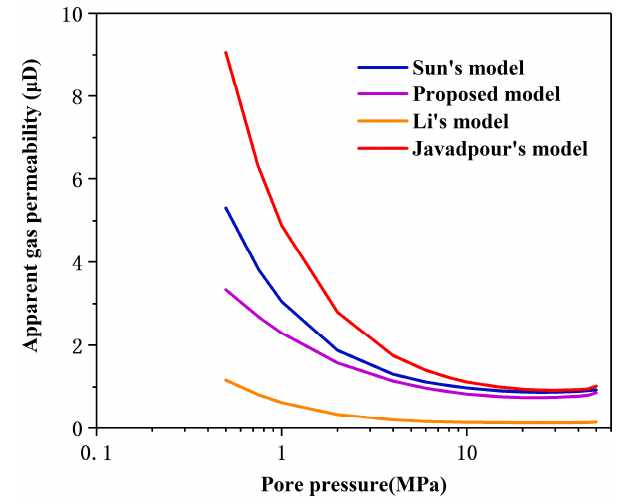
Figure 4. Model validation compared with published models ( r = 5 nm).